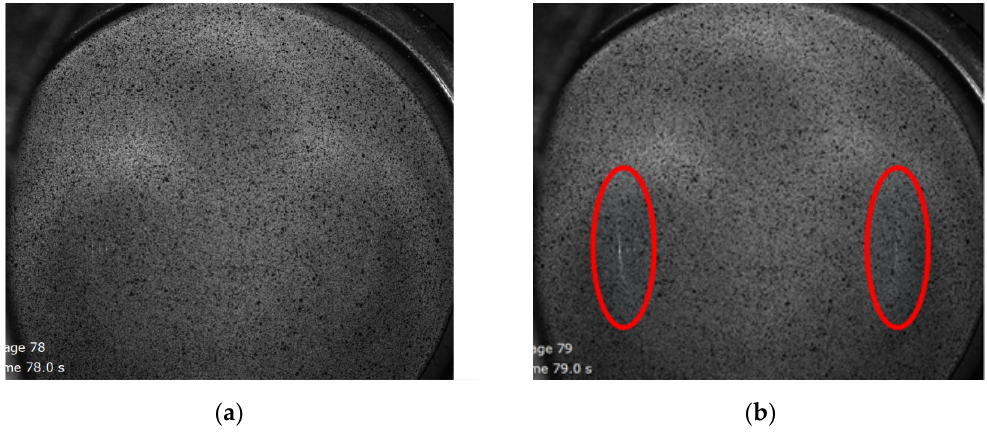
Figure 7. Surface of the deformed AA5754 tailor-welded blanks with thickness 2.2 mm: ( a ) prior to fracture (stage 78) and ( b ) after fracture (stage 79). The location of red circle is the fracture location.